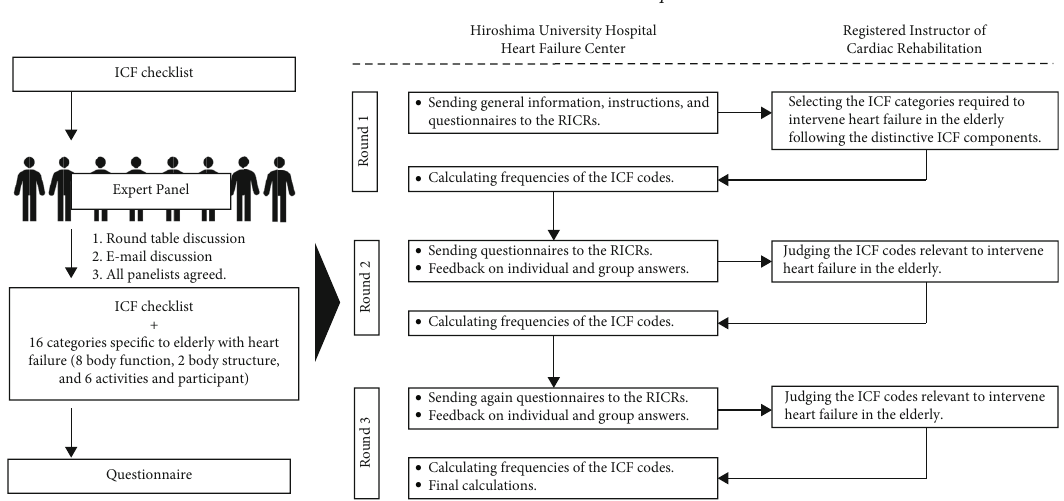
Figure 1: Schematic representation of the research process. Table 2: The consensus process from the fi rst to the third Delphi